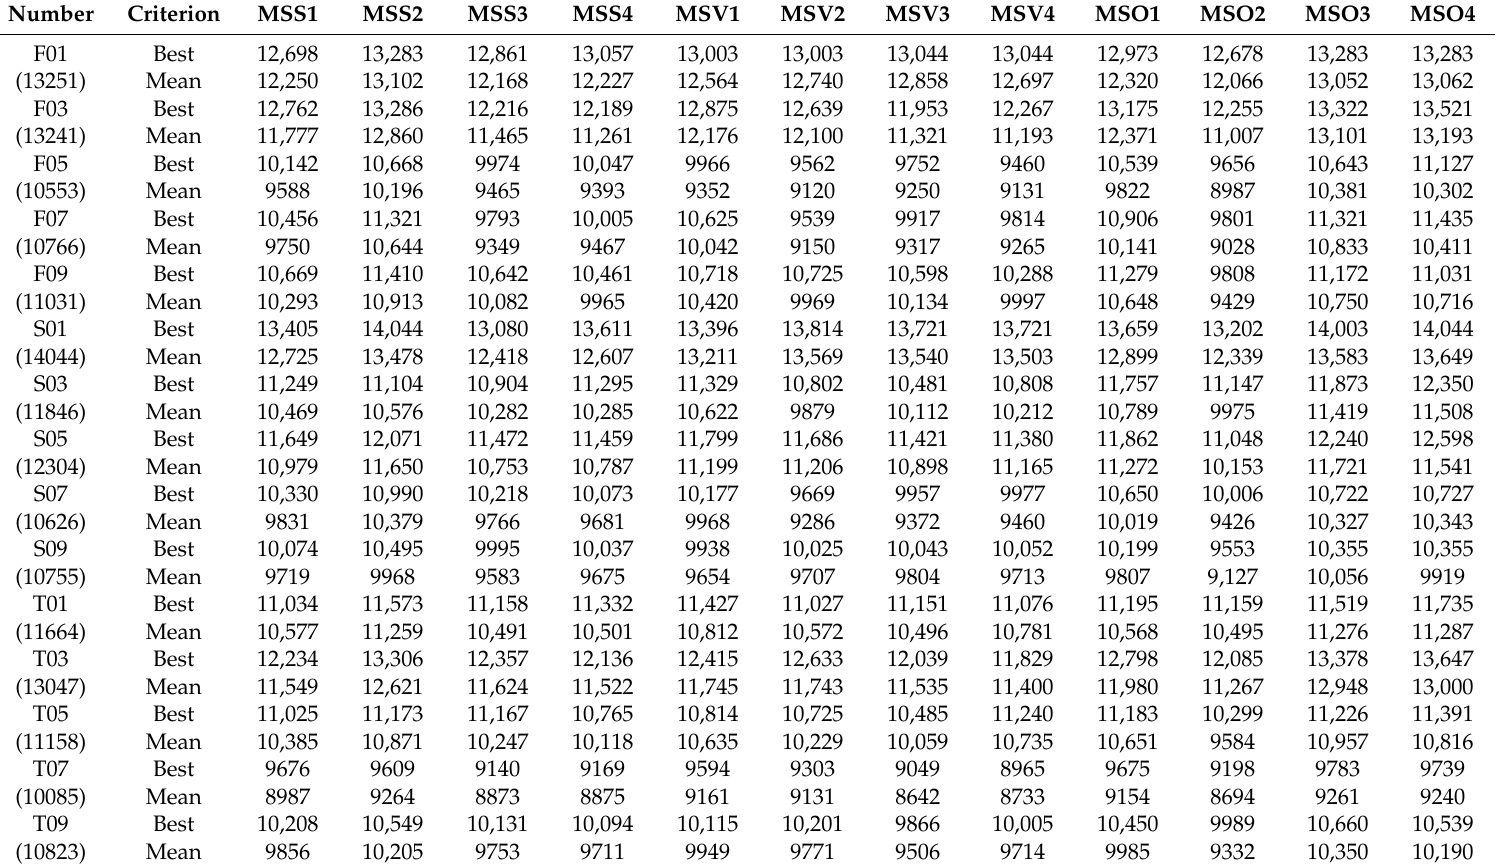
Table 4. The best values and average values of twelve discrete MS algorithms on 15 SUKP